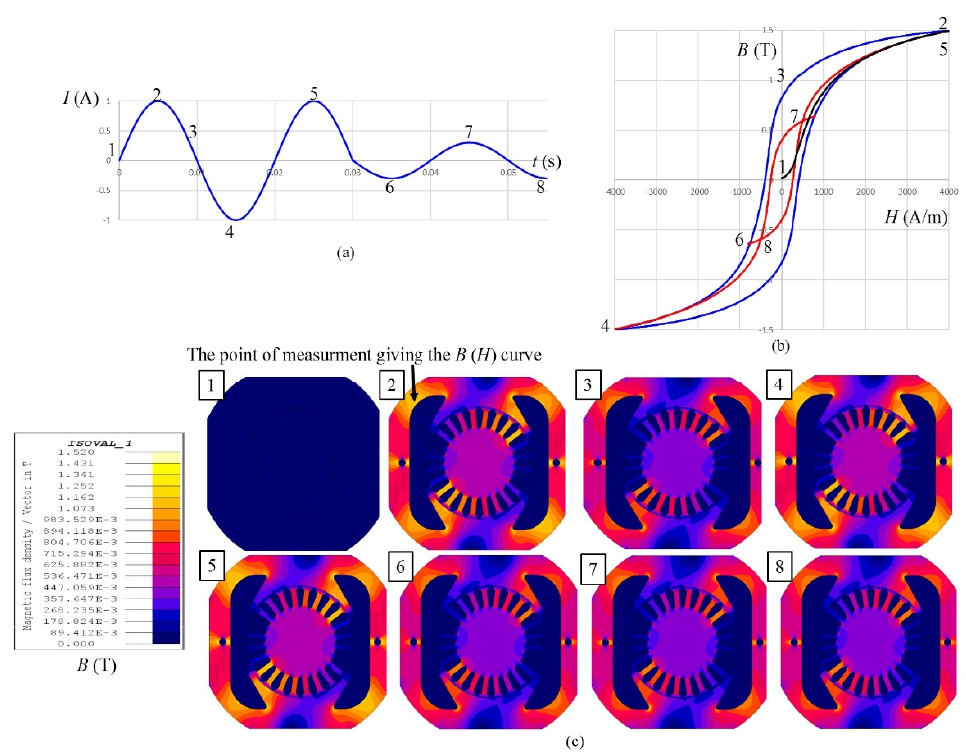
Figure 1. Schematically presented magnetization using hysteresis: ( a ) Excitation current; ( b ) Hysteresis loop; ( c ) Magnetic flux density in the cross-section of the motor